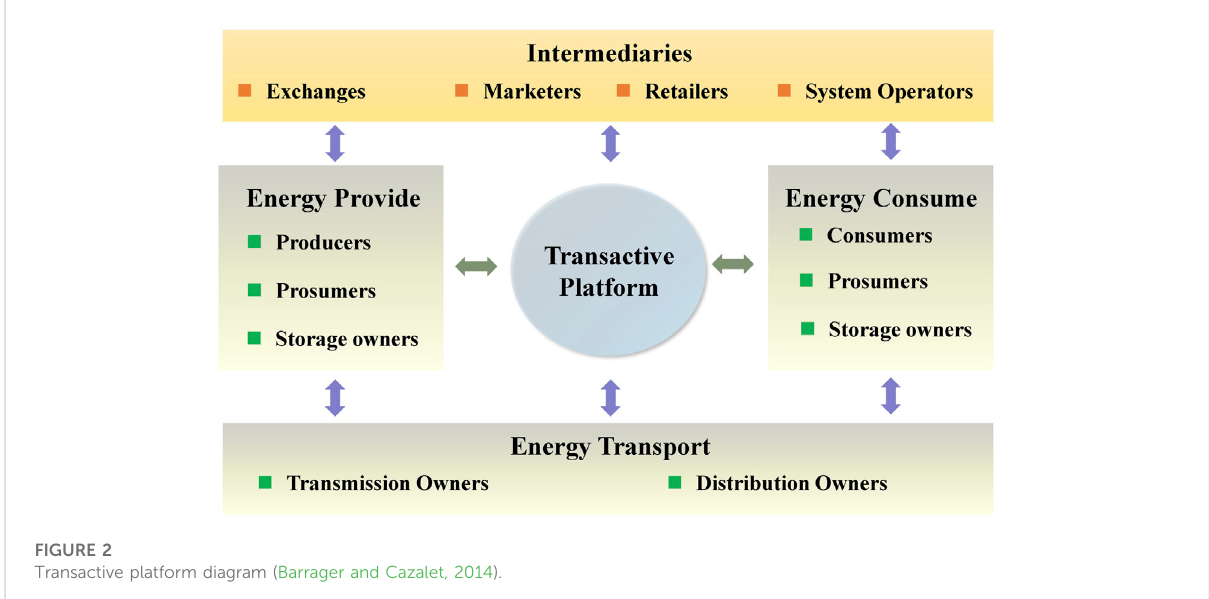
FIGURE 2 Transactive platform diagram (Barrager and Cazalet, 2014).